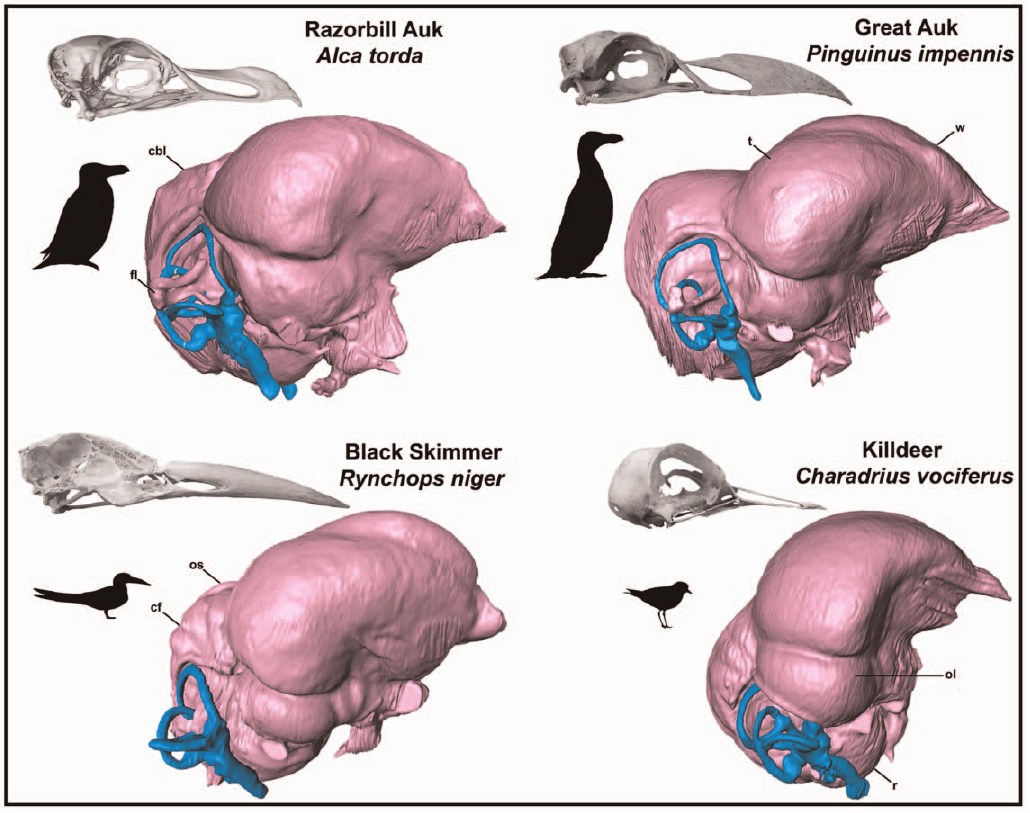
Figure 16. Endocranial endocasts of the Razorbill Auk Alcatorda (A), Great Auk Pinguinusimpennis (B), Black Skimmer Rynchopsniger (C), and Killdeer Charadrius vociferus (D) in right lateral view (not to scale for comparison). These four endocasts illustrate the morphological differences between aquatic versus terrestrially foraging charadriiforms, between R. niger and all other charadriiforms, between wing- propelled diving pan-alcids and other charadriiforms, and between volant and flightless pan-alcids. Note the differences in the dorsal projection of the wulst, the relative size of the optic lobe as compared to the telencephalon, the relative length of the cerebellum as compared to that of the telencephalon, the relative size of floccular lobes, absence or presence of cerebellar fissures and occipital sinuses, and the difference in the relative orientation of the telencephalon, optic lobe, and rhombencephalon between Charadrius vociferus and other figured species. Note that the lateral surface of the skull of R. niger (C) has been cut away to show the position of the cranial cavity.